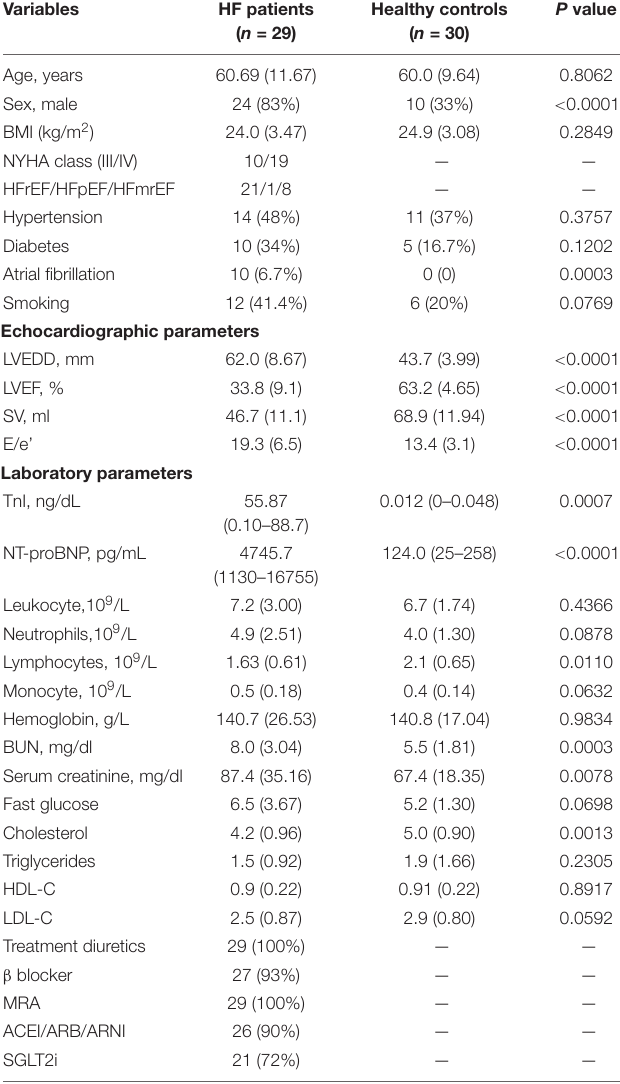
TABLE 1 | Baseline characteristics of the study participants.